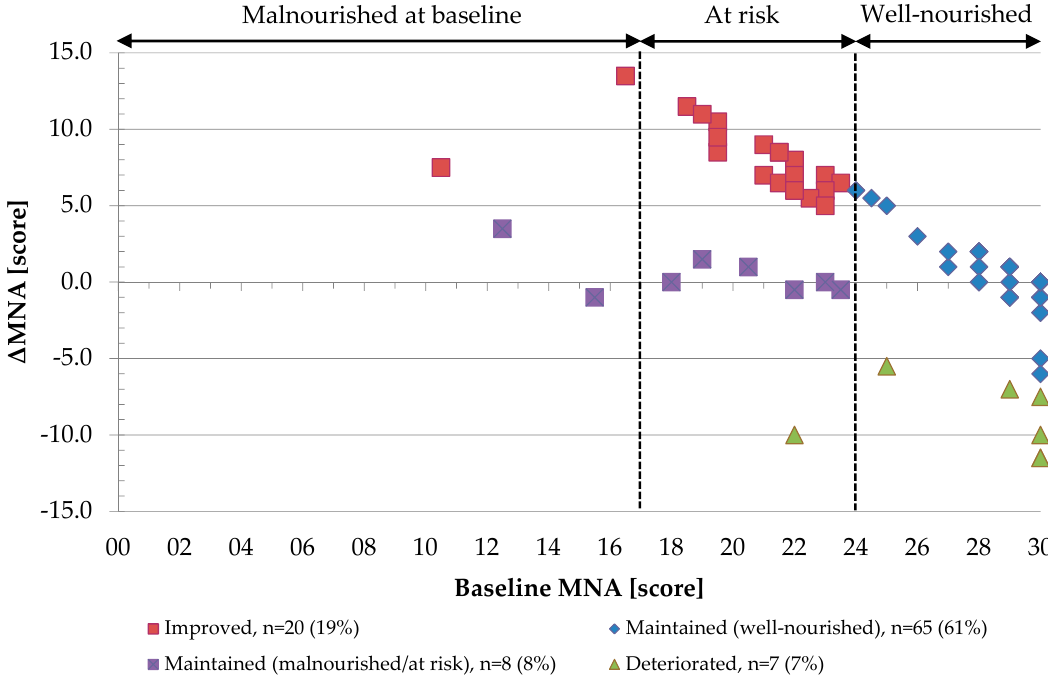
Figure 1. Change in MNA score ( ∆ MNA) by baseline MNA score across subgroups of nutritional status change. One dot represents one individual. Six participants could not be represented due to missing value in MNA score at follow-up.